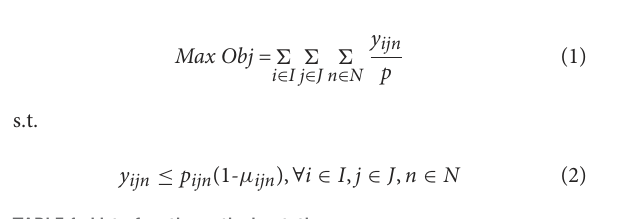
TABLE 1 List of mathematical